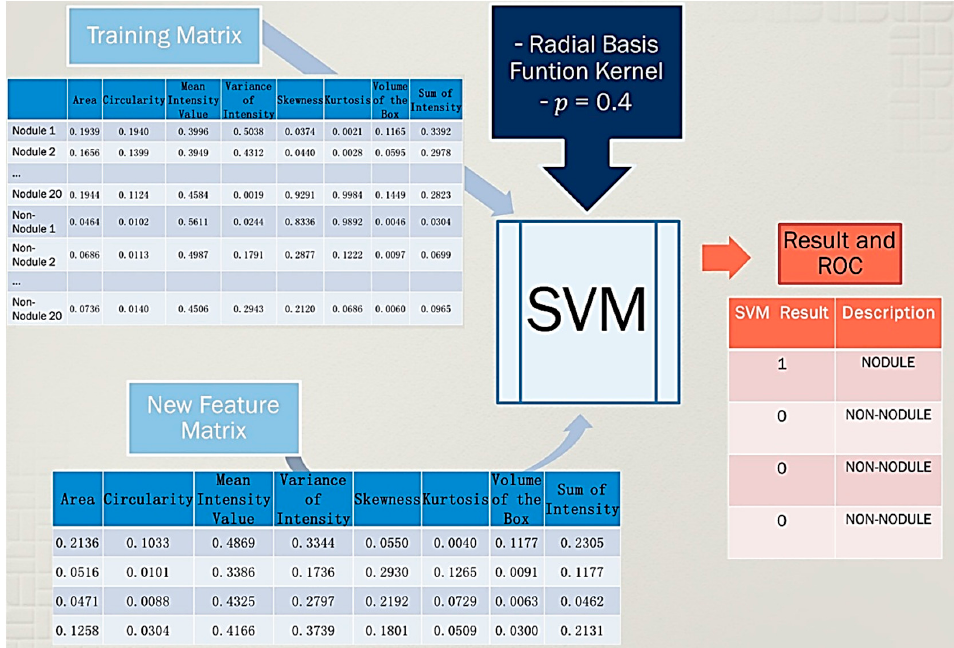
Figure 7. SVM classification procedure with real data of structural characteristics showing four possible candidates and the detection of one nodule and three non ‐ nodule structures.